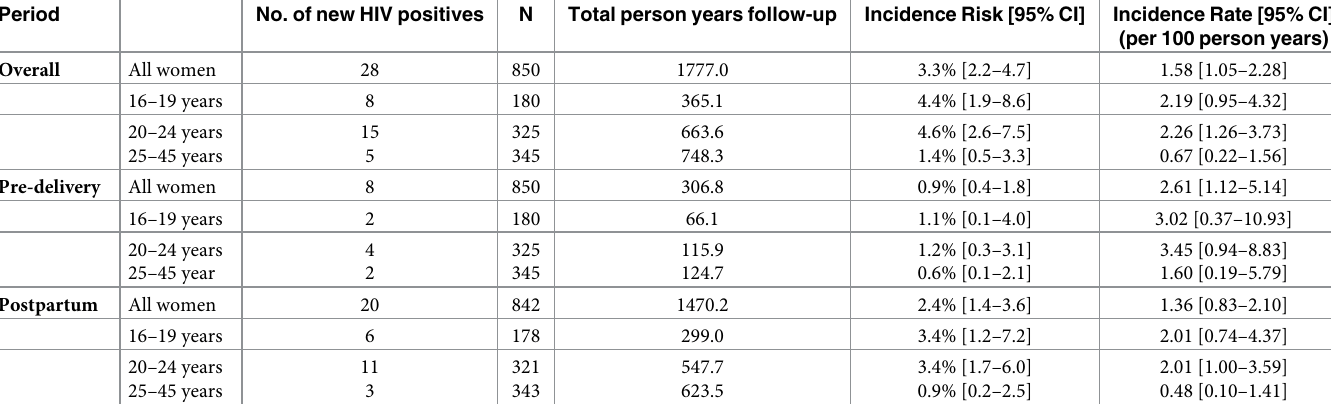
Table 2. Overall, pre- and post-delivery HIV incidence by age group among women attending ANC in Lesotho.